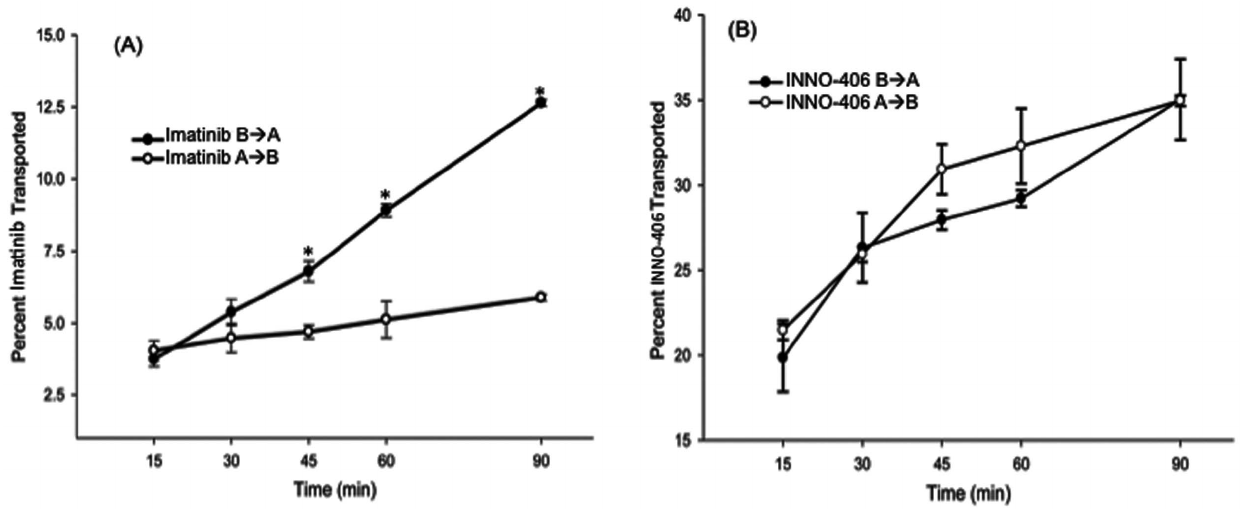
Figure 1. Directional transport of Imatinib (A) and INNO-406 (B) across BBMEC monolayers. The directional transport of two drug analogues Imatinib (A) and INNO-406 (B) were determined in BBMEC. The apical-to-basolateral transport (A R B) (open circles) and basolateral-to- apical (B R A)(closed circles). The data are presented as percent transported as a function of time (means 6 SD, n=3). * Considered statistically significant (p , 0.05).